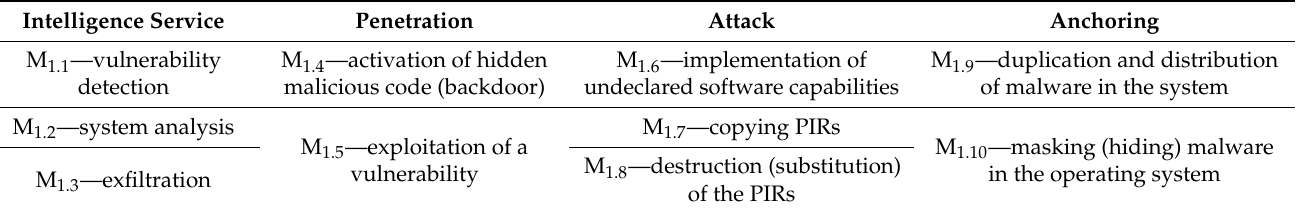
Table 1. Classifier of the model of